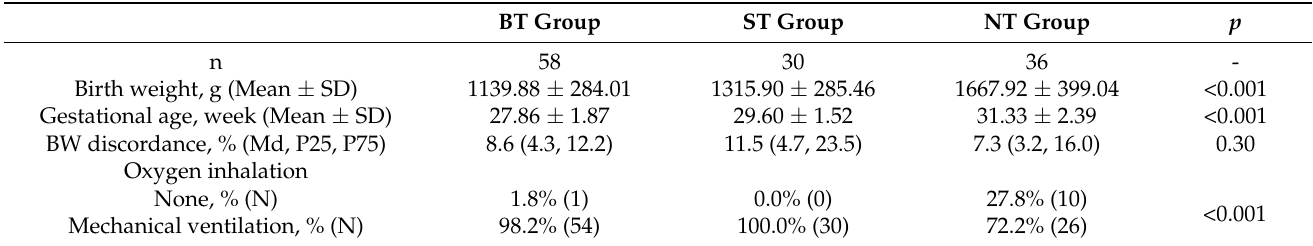
Table 3. Characteristics of infants grouped according to whether both twins received treatment. BT Group